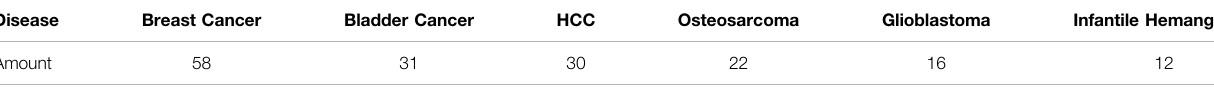
TABLE 6 | Selected circRNA and their amount in CircR2Disease. Disease